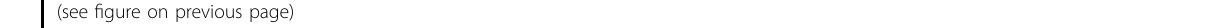
Fig. 4 Epigenetically inherited DMRs correlate with paternally inherited health risks. a DNA methylation levels of the transgenerationally inherited DMR, Chr13:75,929,838-75,930,456, in sperm samples of all generations. b DNA methylation patterns of the transgenerationally inherited DMR in sperm samples. c DNA methylation levels of the transgenerationally inherited DMR in testis tissues. d DNA methylation patterns of the transgenerationally inherited DMR in testis tissues. e Gene expression patterns of Rhobtb3 in testis tissues. f DNA methylation levels of the intergenerationally inherited DMR, Chr10:40,640,103-40,641,054, in sperm samples of all generations. g DNA methylation patterns of the intergenerationally inherited DMR in sperm samples. h DNA methylation levels of the intergenerationally inherited DMR in brain tissues. i DNA methylation patterns of the intergenerationally inherited DMR in brain tissues. j Gene expression patterns of Ddo in brain tissues. ** t -test p -value < 0.01; n.s. no signi fi cant, t -test p -value >